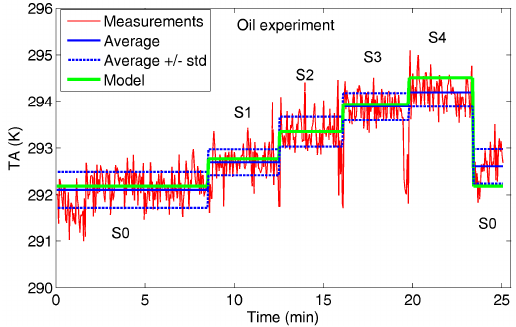
Figure 10. Oil experiment: T A measured by radiometer (red and blue curves) and estimated by model (green curve).